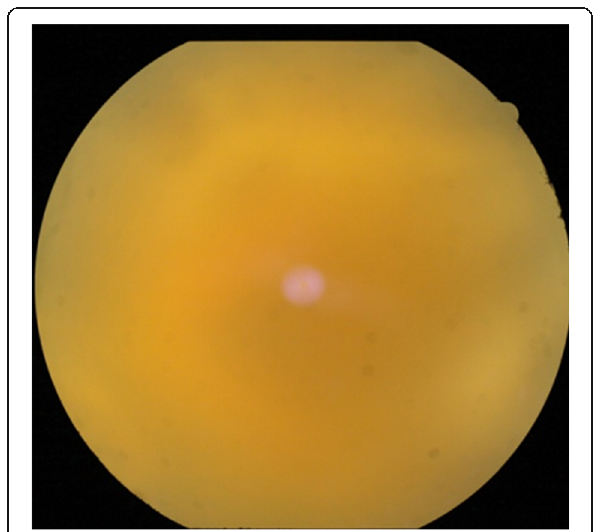
Fig. 2 Poor fundal glow in the left eye